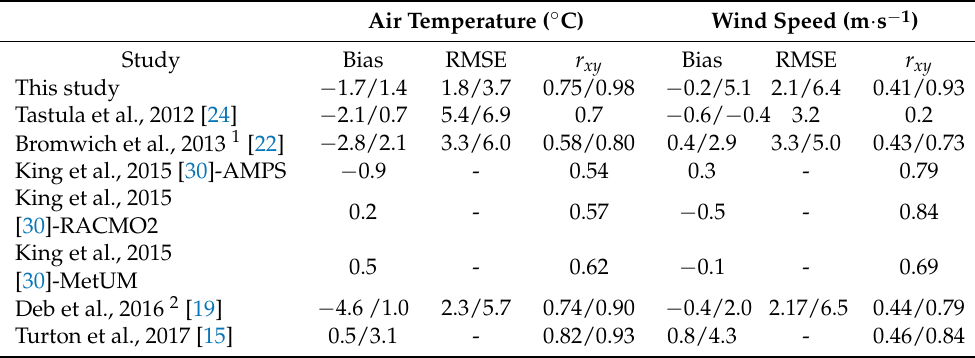
Table 5. Validation statistics for air temperature and wind speed simulations by standard (this study) or Polar WRF in Antarctica. Note: if more values were reported, the minimum and maximum values are shown. Values of bias and RMSE rounded to one decimal point. In addition to the WRF model results, validation statistics of the RACMO2 and MetUM models by King et al. [30] are shown for